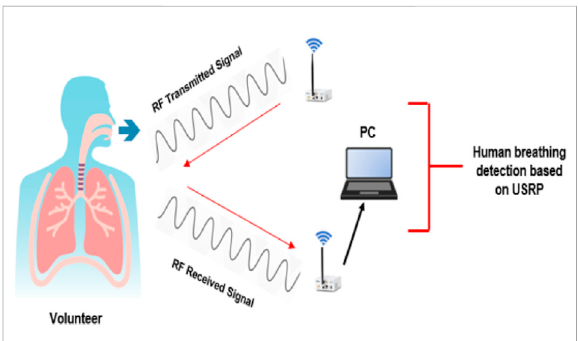
FIGURE 14 Schematic of non-contact breathing detection using Wi-Fi signals (Ashleibta et al.,